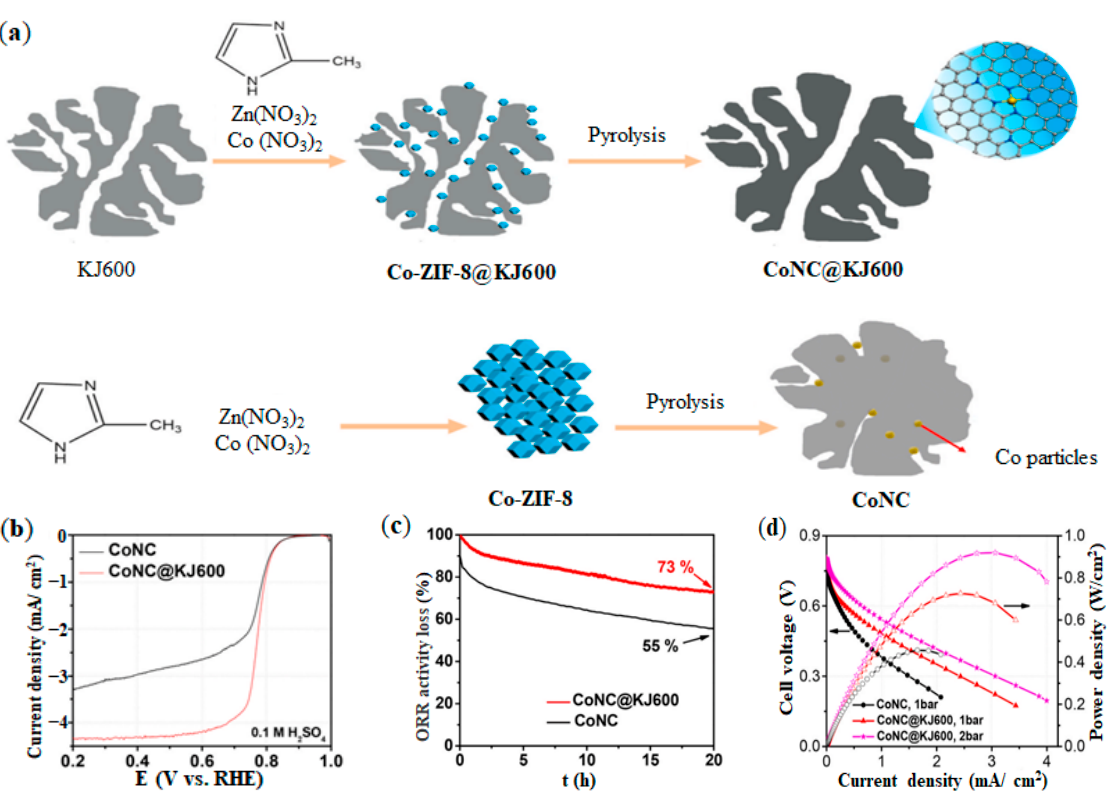
Figure 5. Synthesis method and performance of CoNC@KJ600 and CoNC catalysts: ( a ) Synthesis diagram; ( b ) ORR activity; ( c ) ORR durability; ( d ) PEMFC performance. Adapted with permission from Ref. [84]. Copyright 2020 Elsevier.